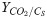
Optimal MDF depending on CO2 assimilation yield YCO2/CS for selected substrate-product combinations in the genome-scale model iJO1366.